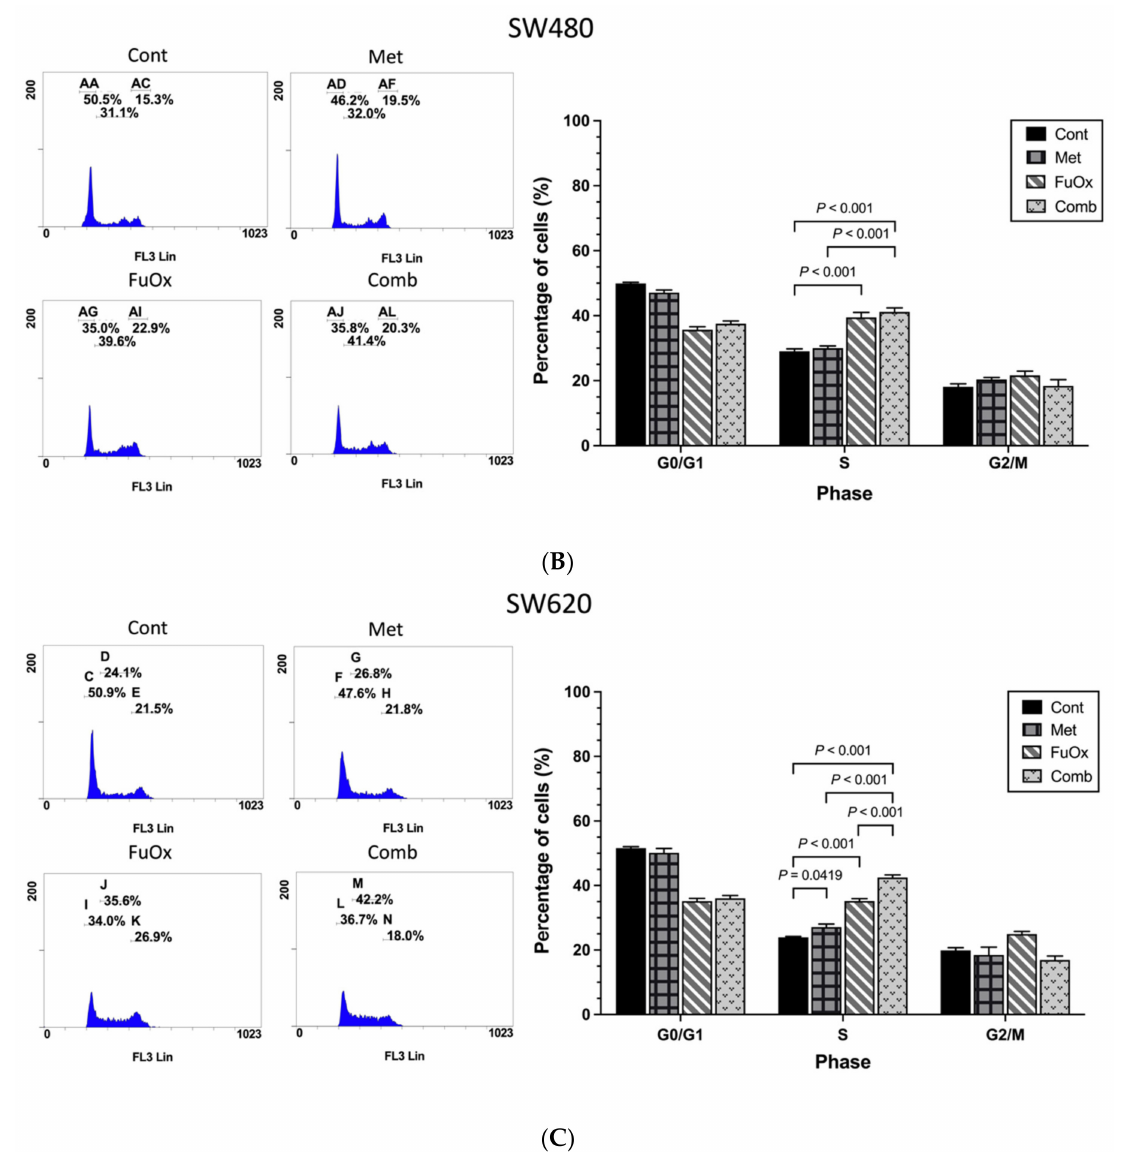
Figure 3. Combination therapy led to cell arrest in different phases in HT29, SW480, and SW620. CRC cells were analyzed using flow cytometry after 24 h of treatment with metformin (5 mM), FuOx (2 µ M), and the combination of metformin and FuOx. Representative flow cytometry results ( left panel) and histograms ( right panel) reveal cell cycle distribution and quantitative analysis, respectively, in ( A ) HT29, ( B ) SW480, and ( C ) SW620 cell lines. Data are presented as mean ± SEM. Cont, control; Met, metformin; FuOx, 5FU and oxaliplatin; Comb, combination of metformin and FuOx. As displayed in Figure 3B, the cell cycle distribution in the SW480 cells treated with metformin alone showed no statistically difference (all p > 0.05). Although treatment with FuOx increased the percentage of cells in the S phase ( p < 0.001), compared with FuOx treatment, metformin combined with FuOx did not significantly increase the proportion of cells in the S phase ( p = 0.7009). In the SW620 cells, the increase in the cell proportion in the S phase in the combination group was prominent compared with the individual treatment groups (all p < 0.001, Figure 3C). Therefore, metformin combined with FuOx induced CRC cell arrest in the HT29, SW480, and SW620 cell